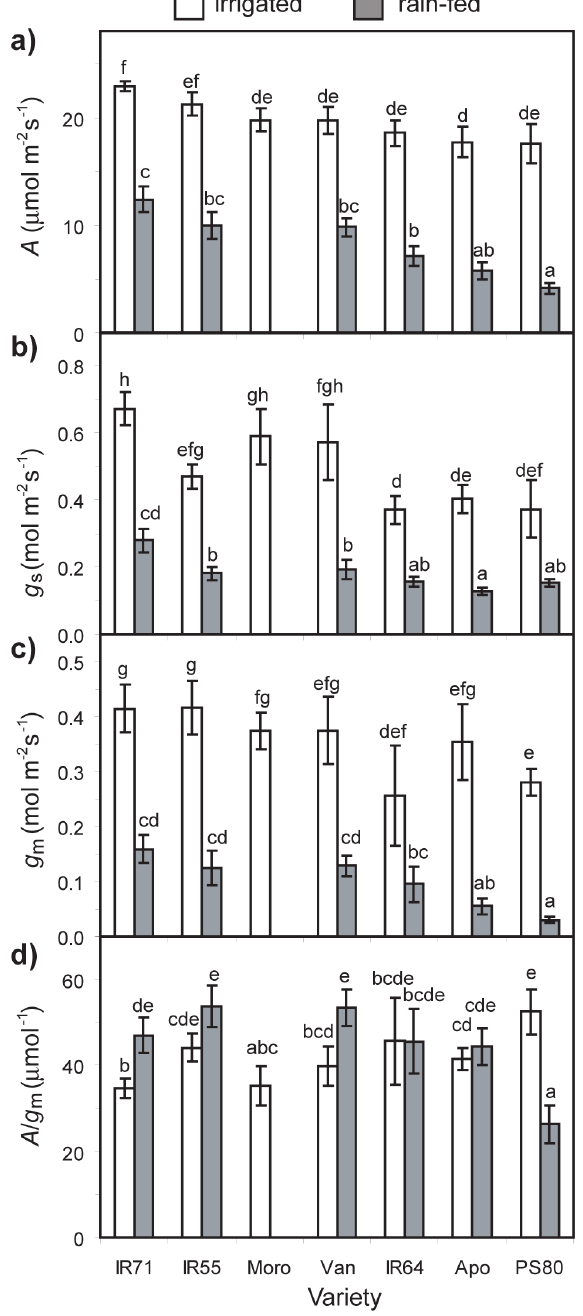
Figure 3. Measurements of (a) photosynthesis rate ( A ), (b) stomatal conductance ( g s ), (c) mesophyll conductance ( g m ), and (d) intrinsic transpiration efficiency ( A / g s ) in control and water-stressed leaves of the seven Oryzasativa genotypes. The measurements were made on the flag leaf in saturating PPFD (1400 m mol m 2 2 s 2 1 ), with relative humidity ranging between 45–55%, and a leaf temperature of 30 u C. Data are means of 4 to 7 plants per treatment. Error bars as in Figure 1. Different letters denote significant differences among means derived using a factorial ANOVA and Tukey post-hoc test.